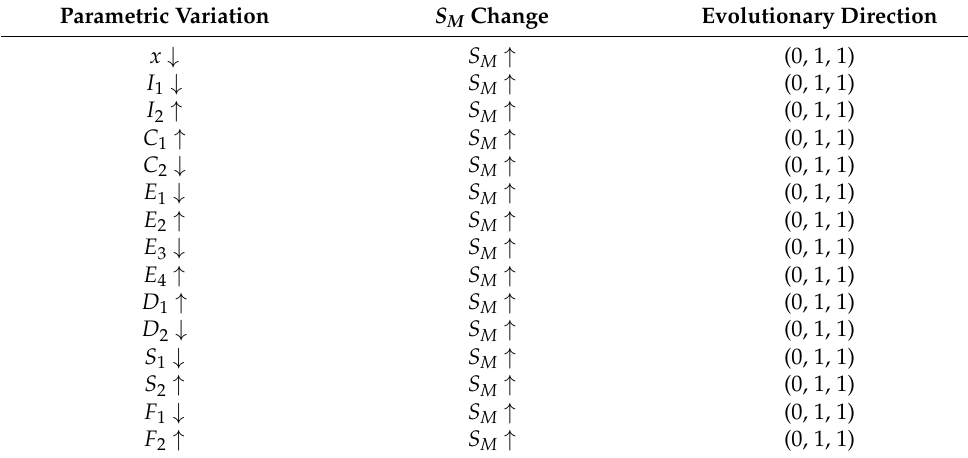
Table 4. Correlation Analysis of System Parameters.